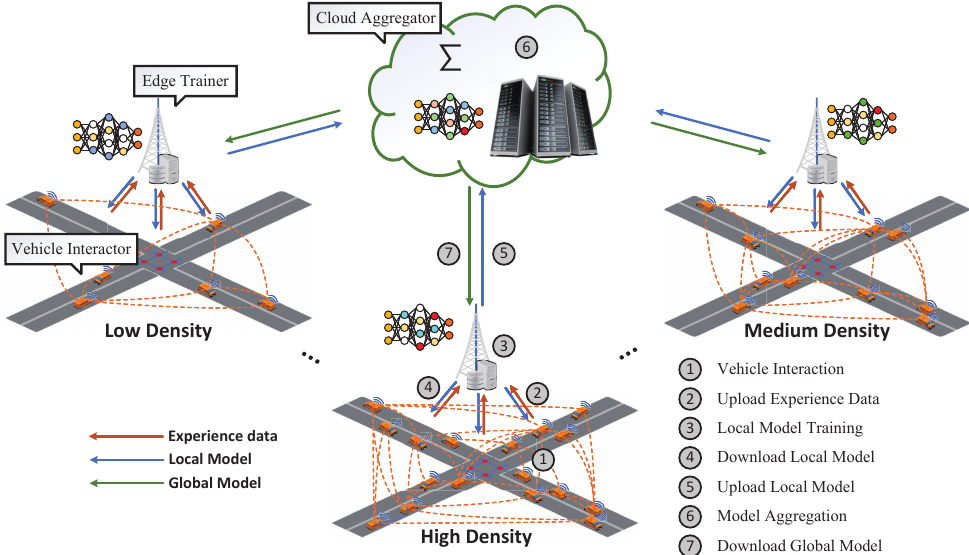
Figure 1. Federated Deep Learning Architecture for Motion